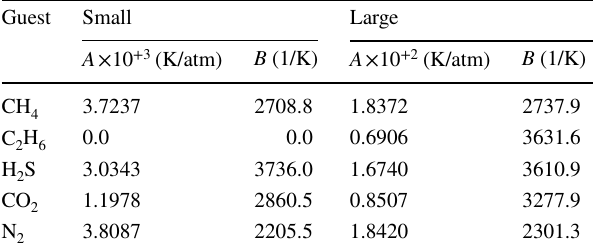
Table 2 Required thermodynamic parameters for van der Waals 4